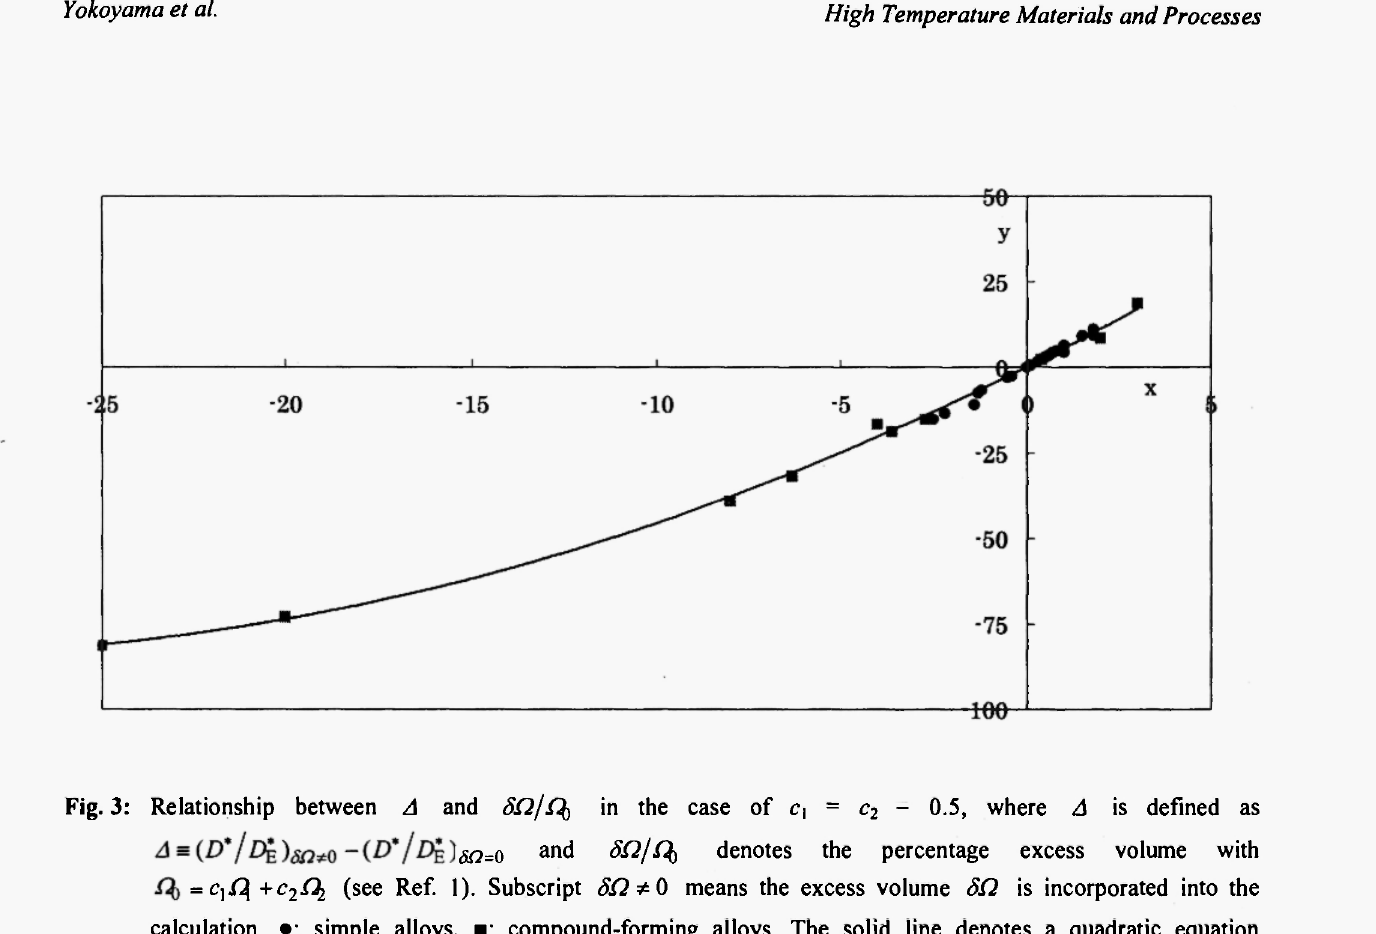
Fig. 3: Relationship between Δ and δΩ/Q in the case of c t = c 2 - 0.5, where Δ is defined as δΩ=ο δΩ/Qj denotes the percentage excess volume with =C]Q + c 2 Q (see Ref. 1). Subscript δΩ φ 0 means the excess volume δΩ is incoφorated into the calculation. ·: simple alloys, •: compound-forming alloys. The solid line denotes a quadratic equation y = 0.0871x 2 + 5.4193* in which y = Δ χ 100 and χ ξ (δΩ/ί^ ) χ 100